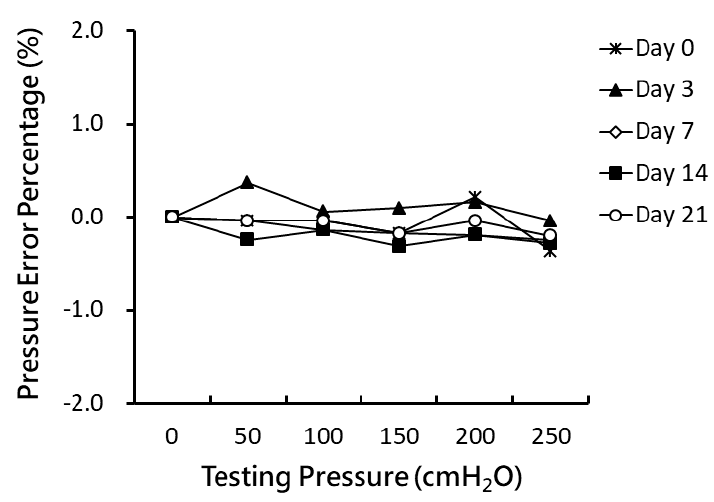
Figure 4. Pressure output errors for various loads of 0~250 cmH 2 O at 50 cmH 2 O increments on days 0, 3, 7, 14, and 21.